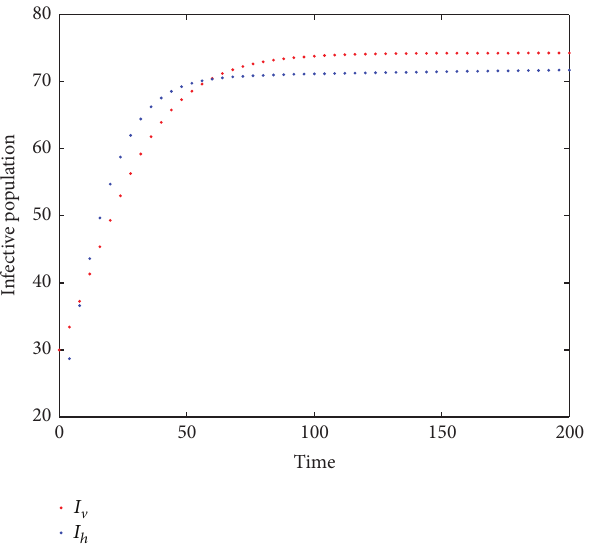
Figure 1: The infected population for Π ℎ = 0.22 , Π V = 0.32 , 𝜇 ℎ = 0.00002 , 𝜔 = 0.003 , 𝜇 = 0.00016 , 𝜃 = 0.00301 , 𝛼 0.0016 , 𝛿 2